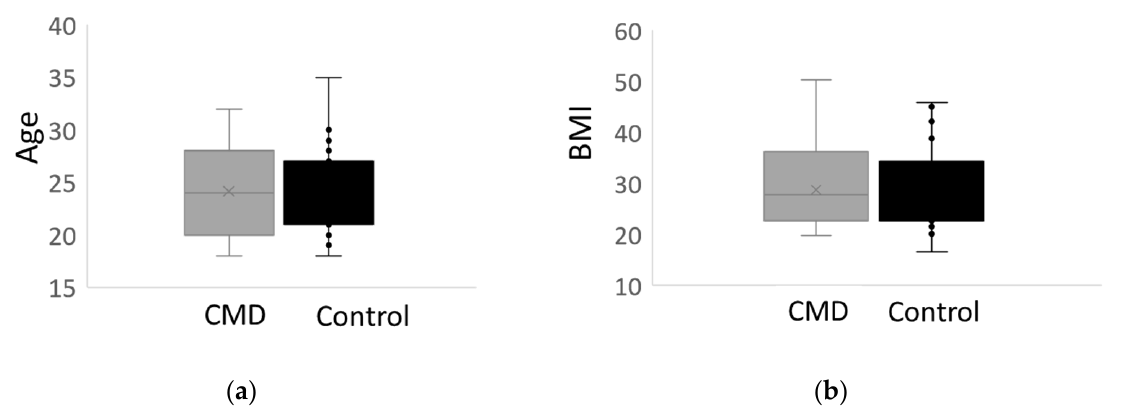
Figure 3. Patient Metadata. ( a ) A whisker plot of the average age of African American women with cardiometabolic disease (CMD) compared to the control group, African American women who delivered at term who do not have cardiometabolic disease. There is no significant difference in the age of the participants. ( b ) Whisker plot comparing the average body mass index (BMI) of the CMD group versus the control group shows that there is no statistical difference in BMI in both cohorts.